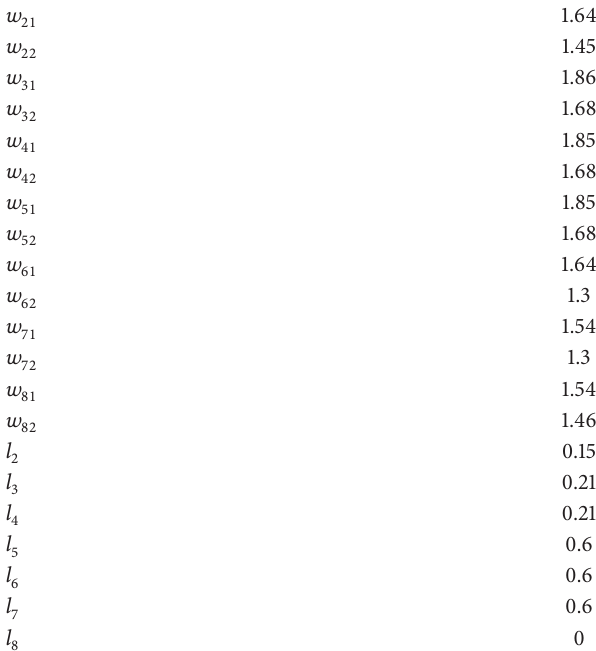
Table 3: Simulated results of each stage single T-junction unequal divider.